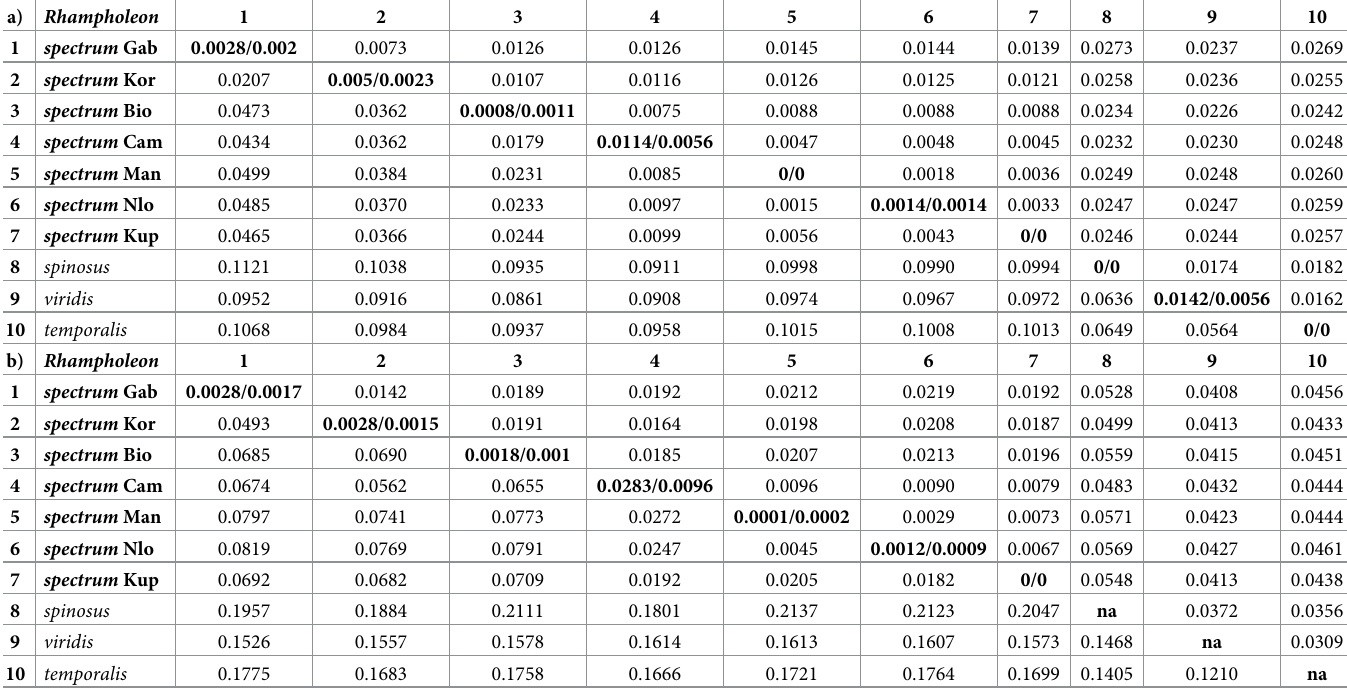
Table 1. Uncorrected p -distances among species (bottom matrix) and standard errors (top matrix) in the genus Rhampholeon and R . spectrum species complex pop- ulations for two molecular markers a) 16S and b) ND4. The values within each species/population are shown in bold on the diagonal ( p -distance/standard error). na denotes not estimated p -distances within species/populations counting only one